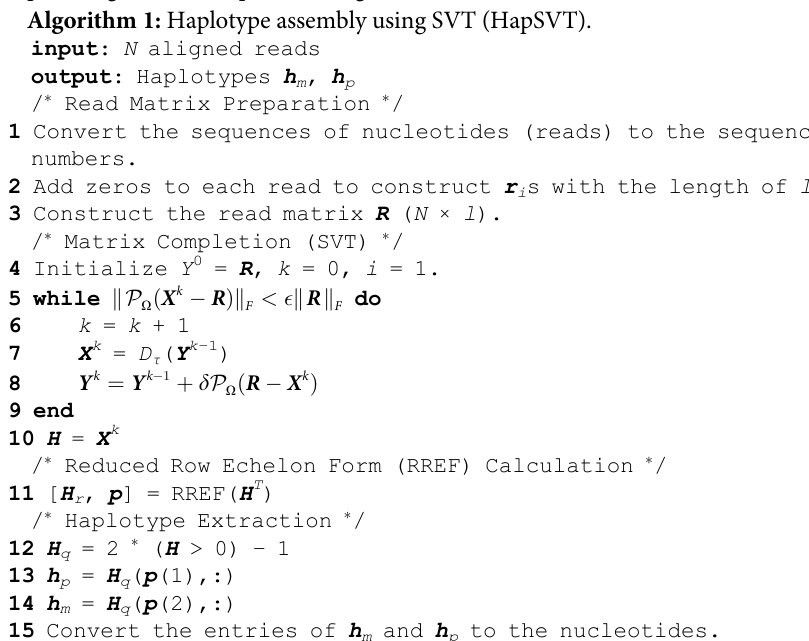
Algorithm 1: Haplotype assembly using SVT